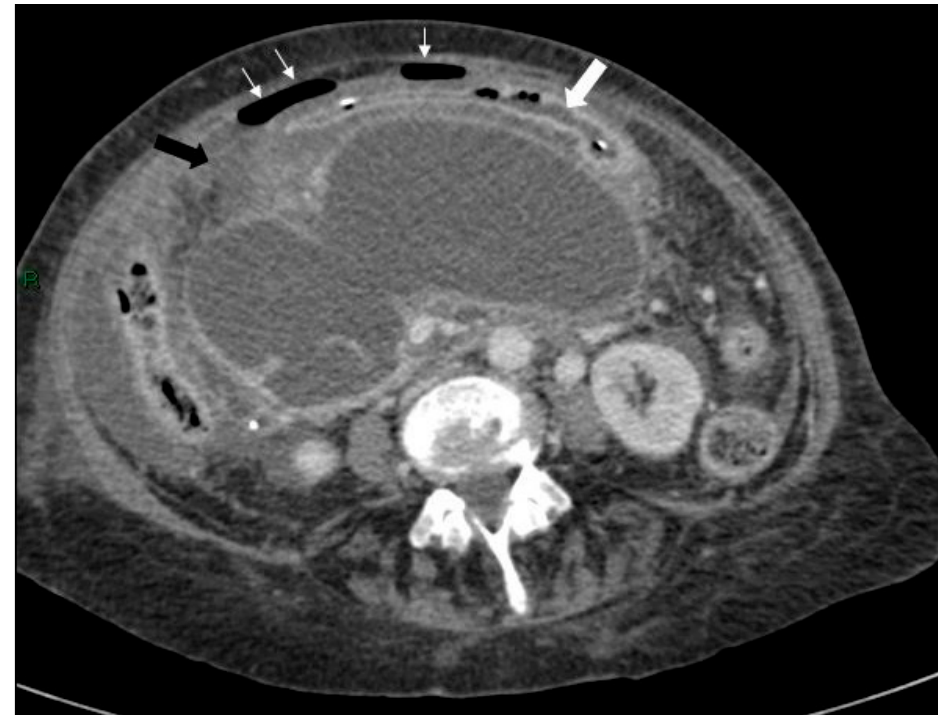
Figure 5. Initially, Axial CT scan showing the stomach containing a nasogastric tube anterior to the cyst (large white arrow), free air (small white arrows) and inflammatory changes in the soft tissues between the stomach/duodenum and the cyst (black arrow).